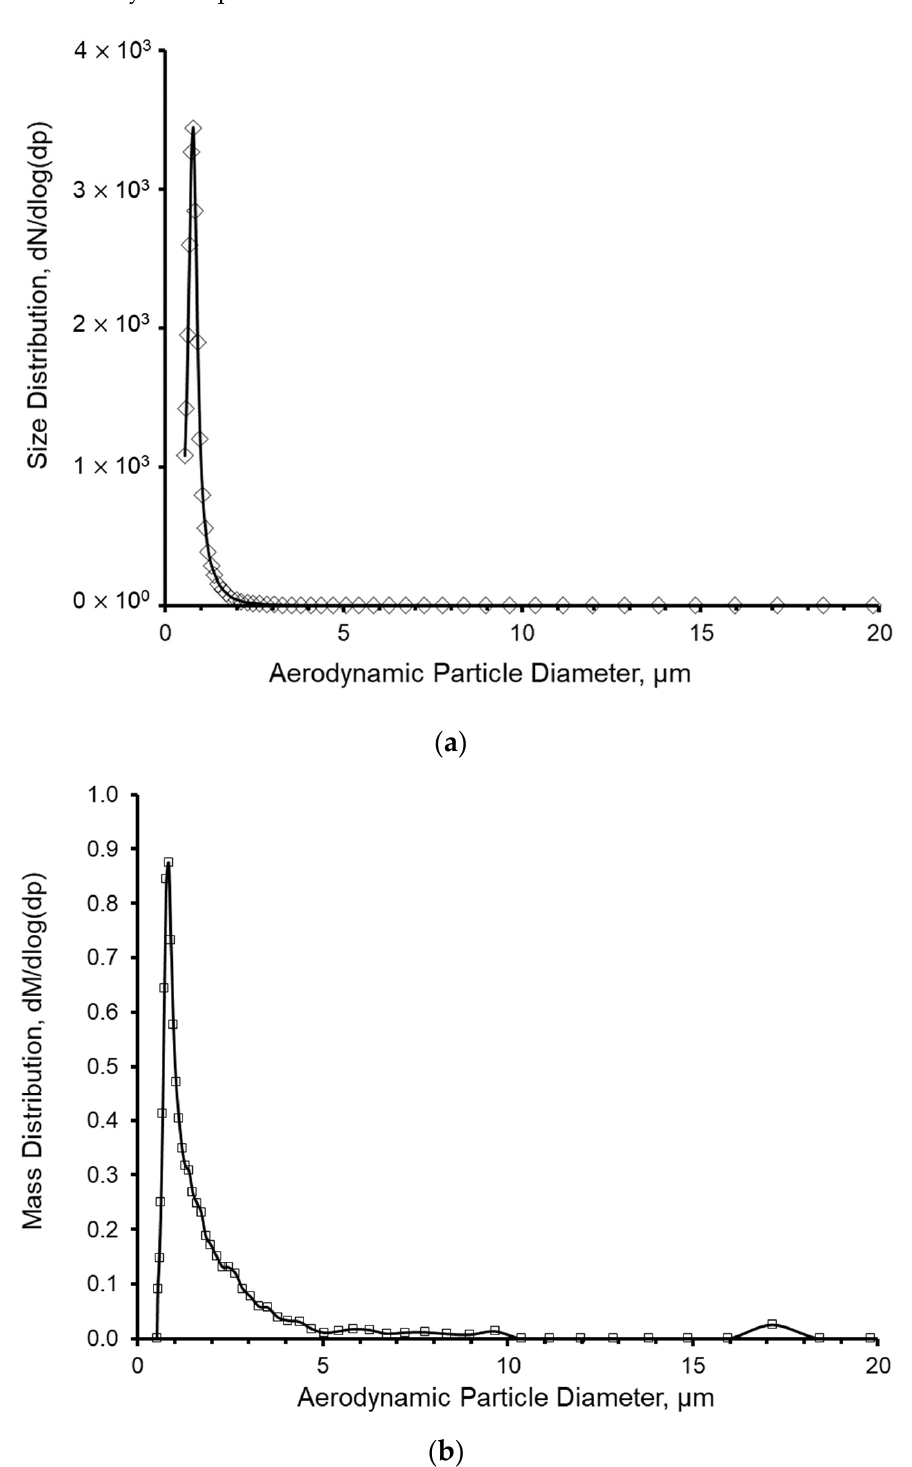
Figure 1. ( a ) The size distribution of droplets given by dN/dlog(dp). ( b ) The mass distribution given by dM/dlog(dp) during the aerosolization of the E. coli MG 1655 suspension.